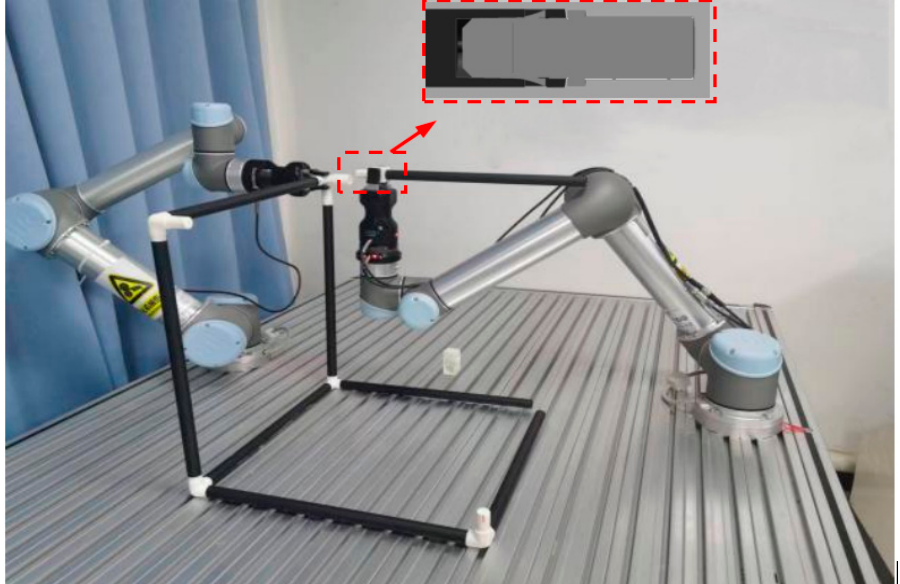
Figure 5. The setup of the experimental system.